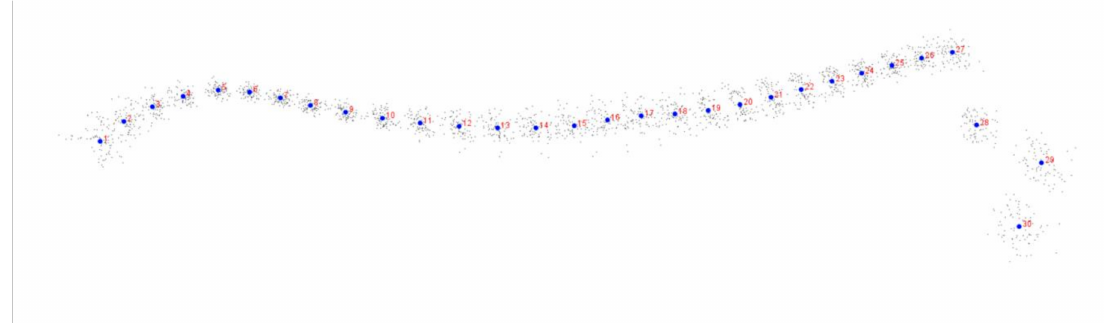
Figure 3. Procrustes coordinates of the donkey data set. Blue points represent the consecutive landmarks marked with increasing numbers from the first caudalis vertebra (1) to the tuber faciale (30).